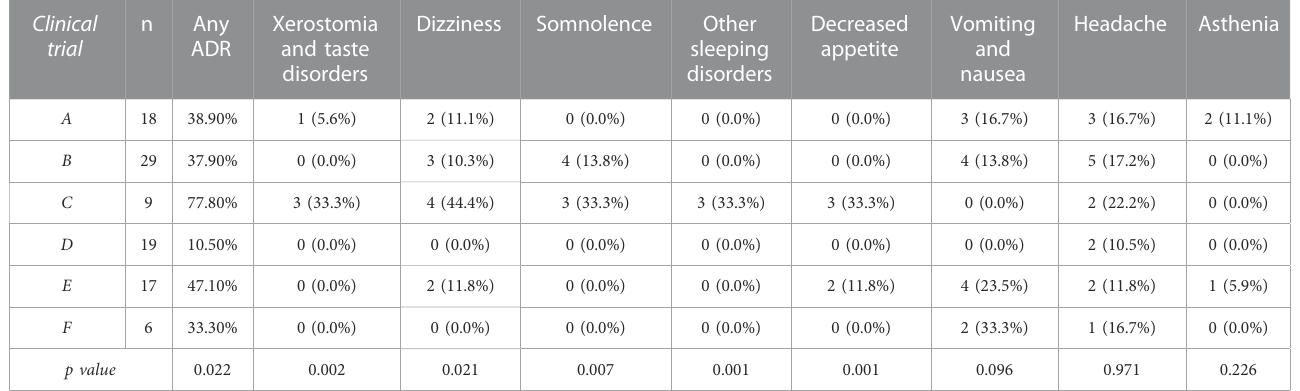
TABLE 6 Incidence of ADRs according to clinical trial design. Clinical